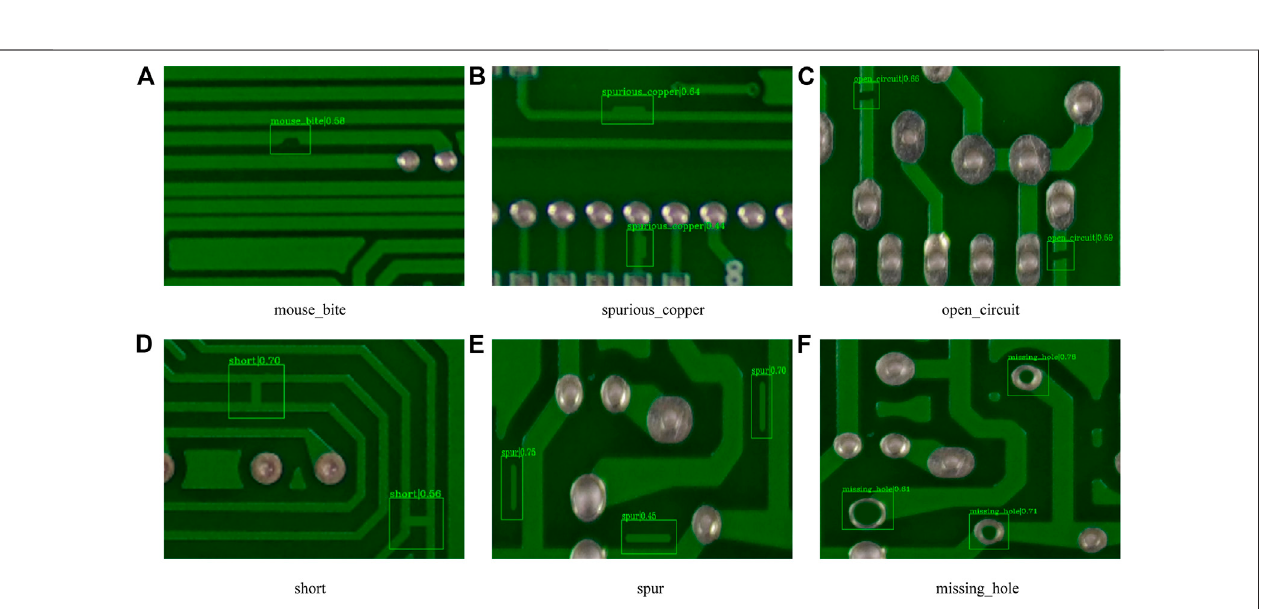
FIGURE 10 | The detection effect of our algorithm on six common defects.